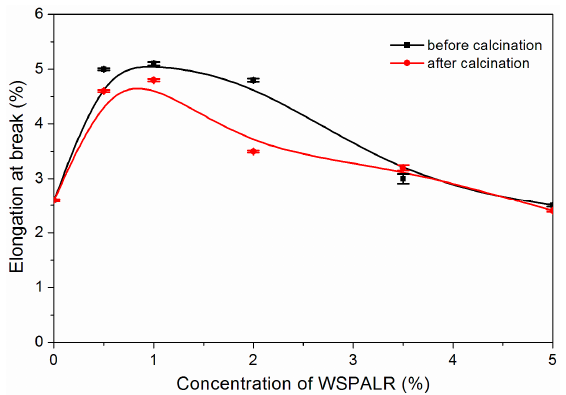
Figure 9. Effect of WSPALR and high-temperature calcined WSPALR on the elongation at break of coatings.